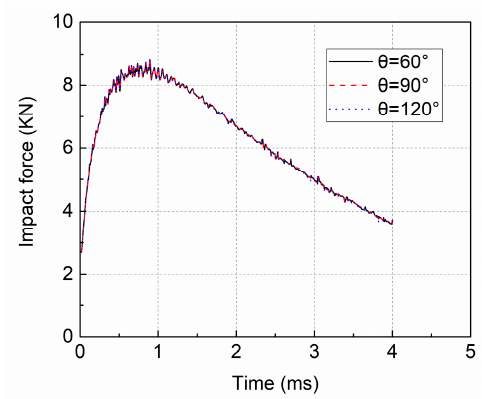
Figure 6. The impact force with different contact angles during the free-fall water entry of the sphere.